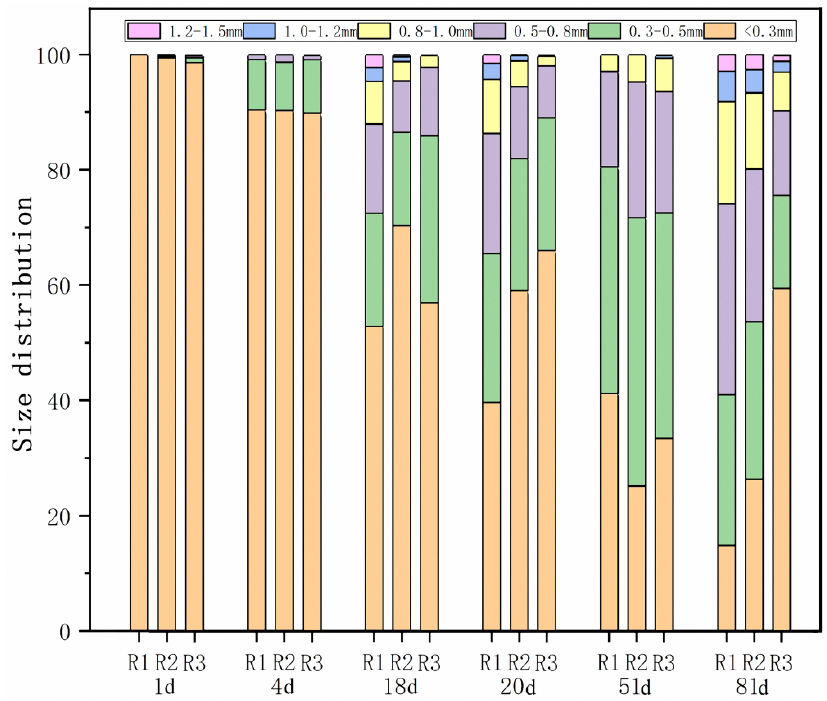
Figure 5. The granularity distribution in the formation process of aerobic granules in R1, R2, and